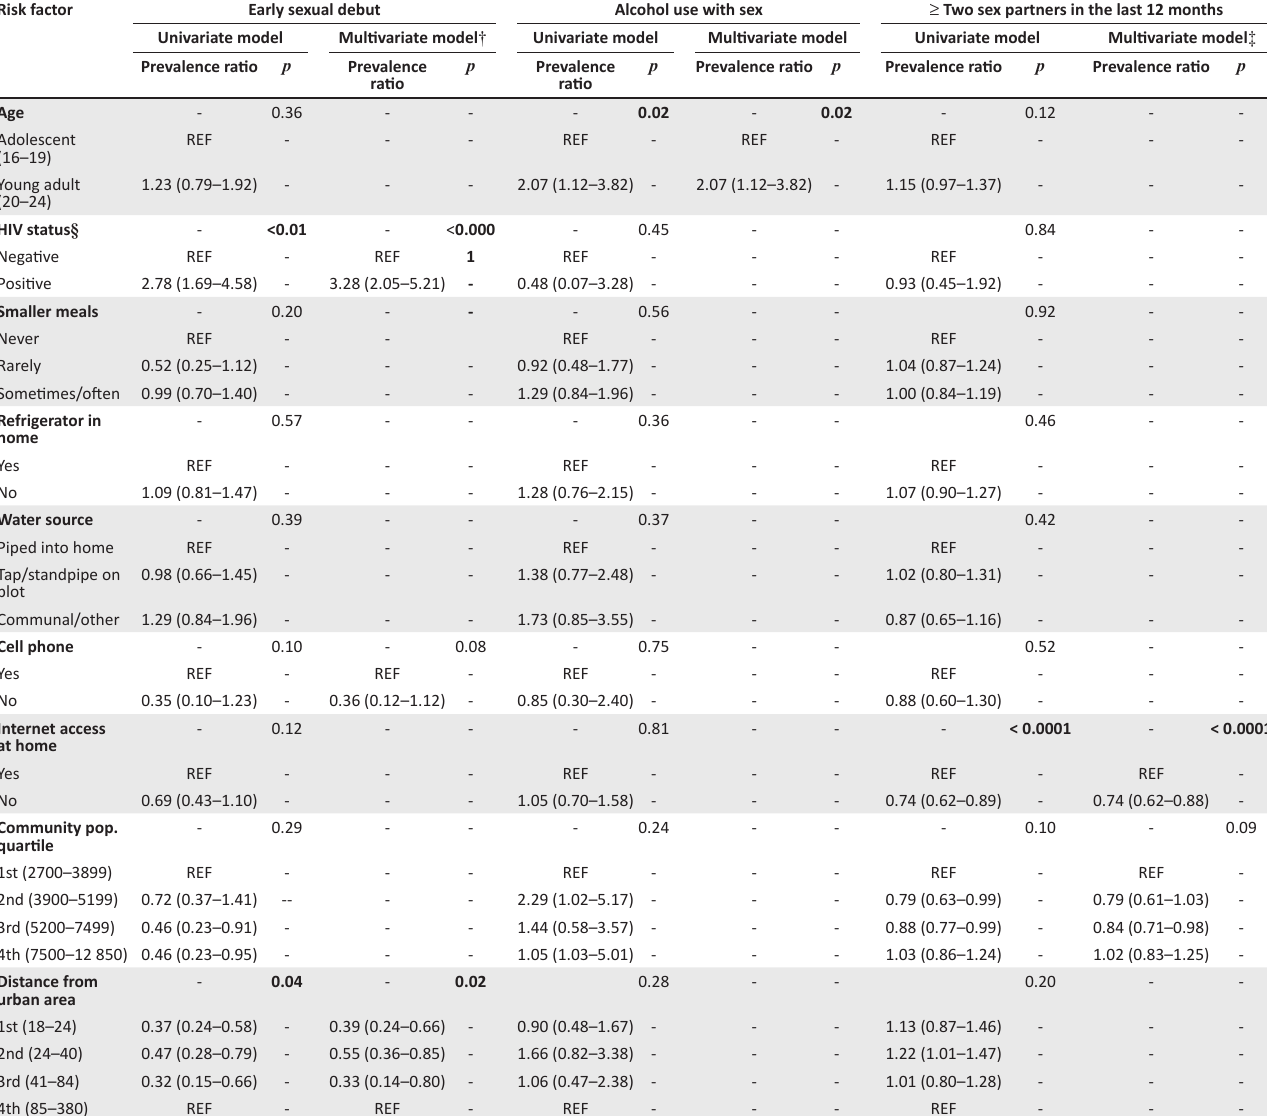
TABLE 4: Univariate and multivariate modelling of factors for risky sexual practices among male adolescents and young adults. Risk